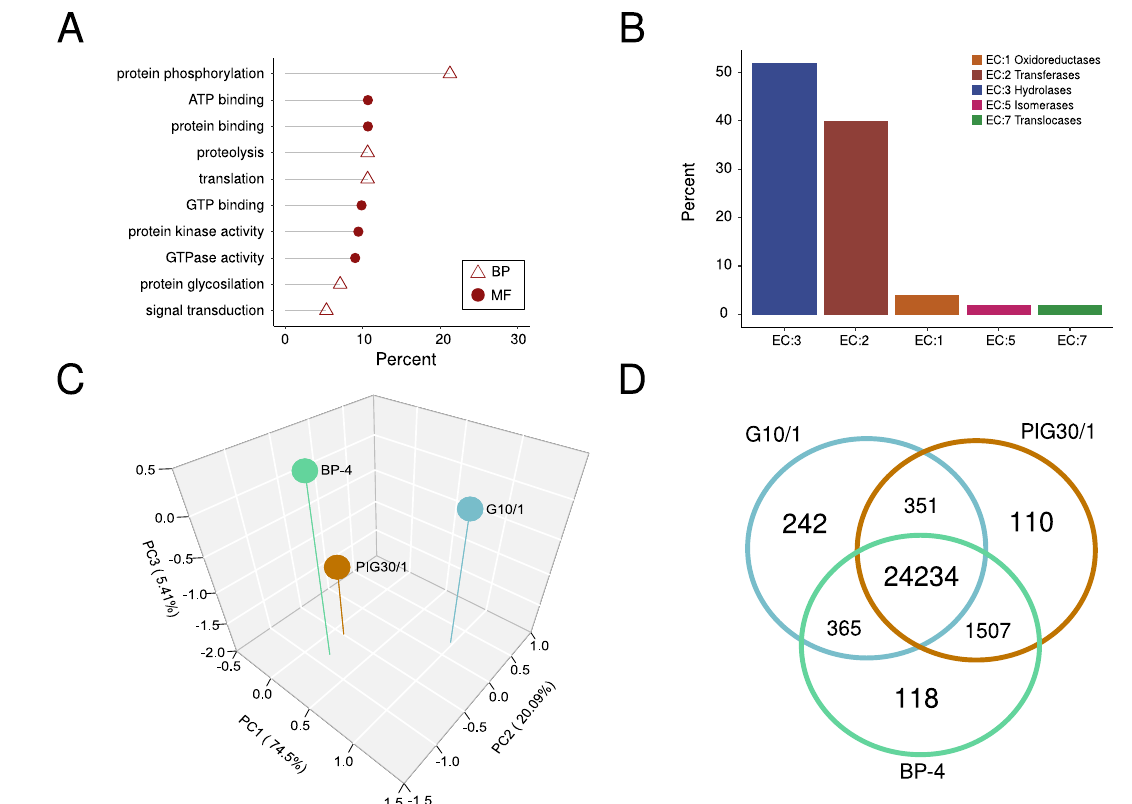
Figure 1. Exploring Tritrichomonas foetus transcriptome assembly. ( A ) Molecular functions and biological processes assigned to new assembled transcripts in this work; Percent: Counts of gene ontology terms represented as percent values for biological process or molecular functions; BP: Biological Processes, MF: Molecular Functions ( B ) Enzyme Commission number (EC) annotation; Percent: Counts of EC represented as percent values for each EC class; ( C ) Principal component analysis for the transcripts abundance (FPKM) data set. Colored points represent a dimensional reduction of transcript expression data for each isolate; ( D ) A Venn diagram that highlights differences and similarities between isolates at transcript abundance